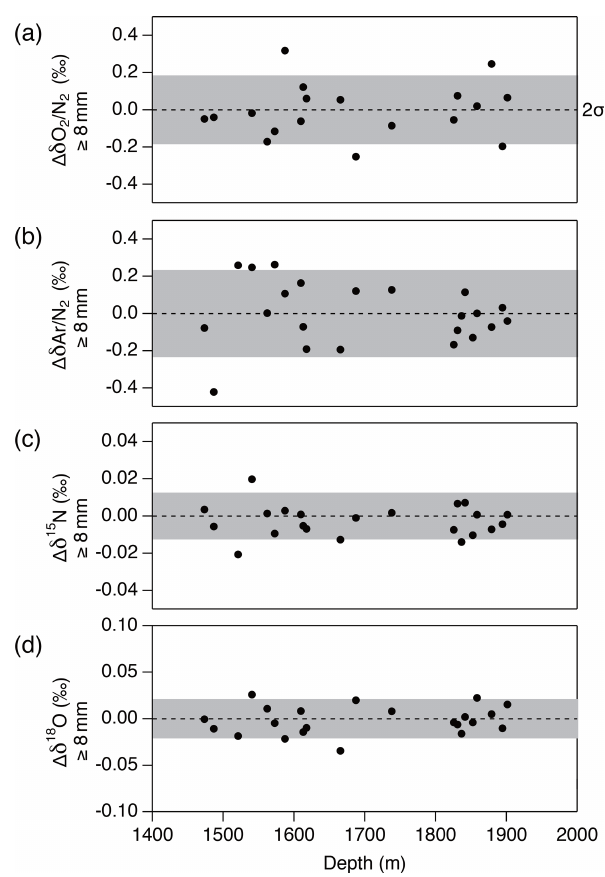
Figure 15. Pair difference between the two inner ice pieces (data from the “b” piece minus that from the “a” piece) whose outer parts are removed by 8mm or more for (a) δ O 2 / N 2 , (b) δ Ar / N 2 , (c) δ 15 N and (d) δ 18 O. Grey shadings indicate the estimated 2 σ uncertainty for clathrate ice (from pooled SDs of